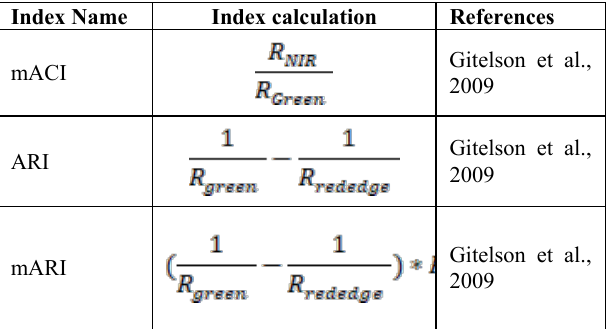
Table 2.Remote sensing Indices for anthocyanin measurement